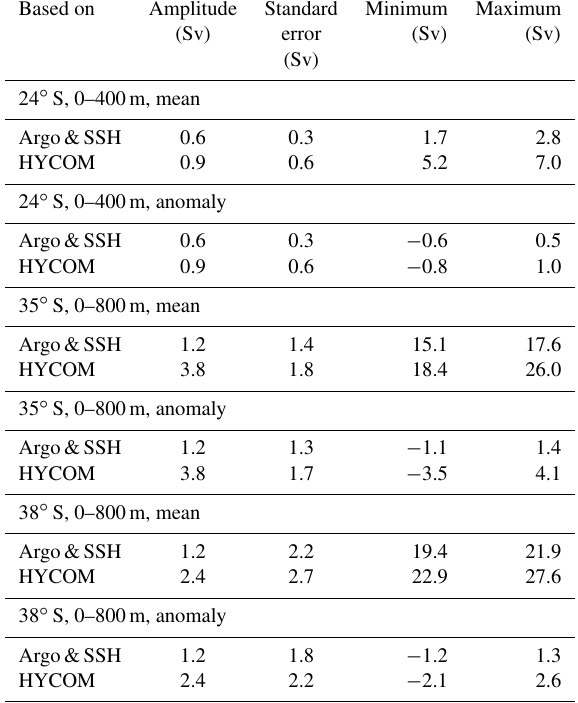
Table 3. Statistics and characteristics of the annual cycle of trans- ports of the Brazil Current. Estimates are derived from the time se- ries in Fig. 5 (for Argo&SSH, see text and Fig. 6).